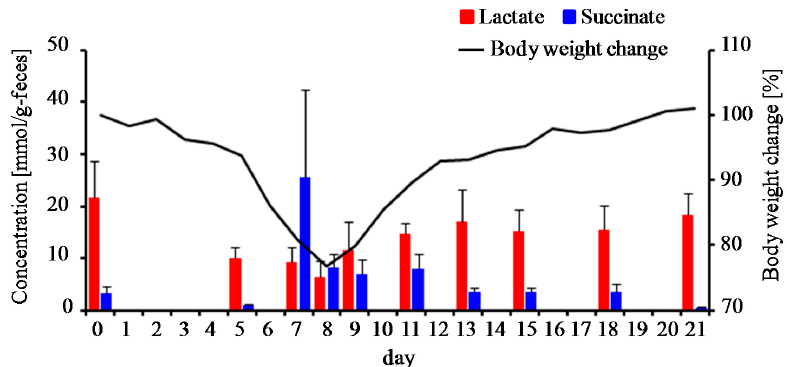
Figure 5. Monitoring of fecal lactate and succinate levels in DSS-treated mice. The solid lines show the average body weight change of five mice during the experimental period. Data of fecal lactate and succinate levels are mean ± standard error of the mean (SEM) ( n = 5).